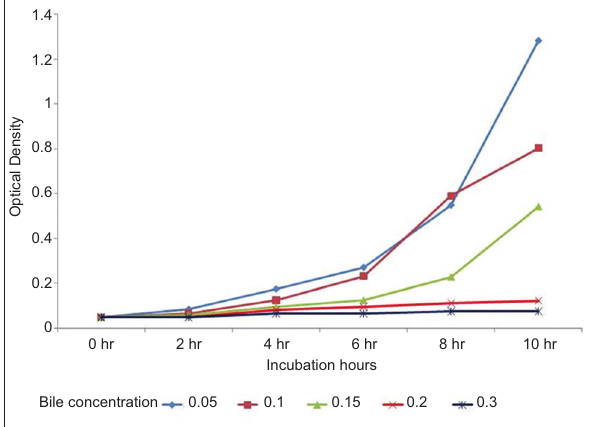
Figure-4: Optical density of de Man Rogosa Sharpe medium containing Lactobacillus acidophilus at various bile concentrations measured at 2 hourly intervals at 650 nm.